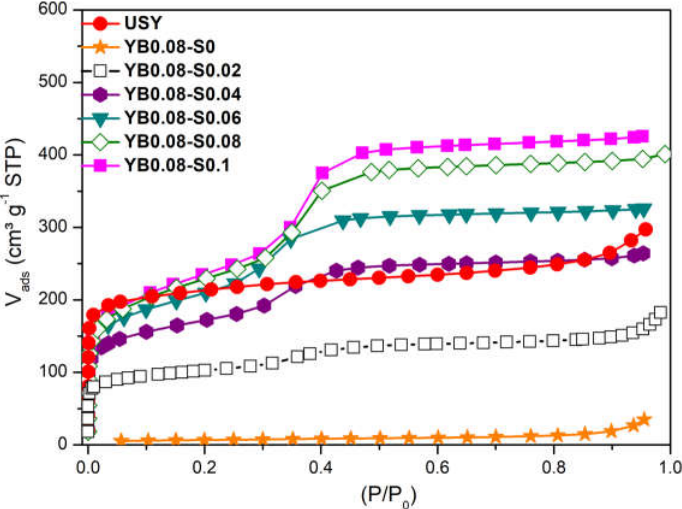
Figure 3. N 2 physisorption isotherms for the original USY zeolite and the modified zeolites produced using different surfactant concentrations.